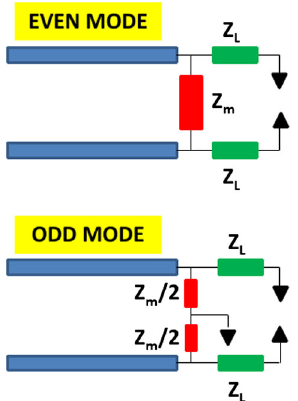
FIG. 22. Method for matching the characteristic impedance for both odd and even modes: adding a matching resistor allows for a tuning of the odd mode characteristic impedance while the even mode characteristic impedance is